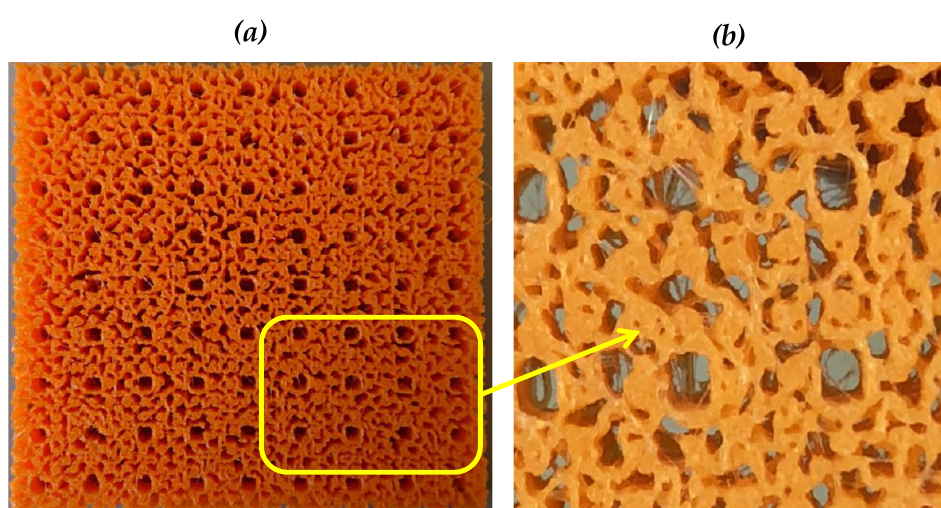
Figure 14. 3D-printed porous structure: ( a ) 3D-printed porous structure; and ( b ) a magnified view of the printed structure.